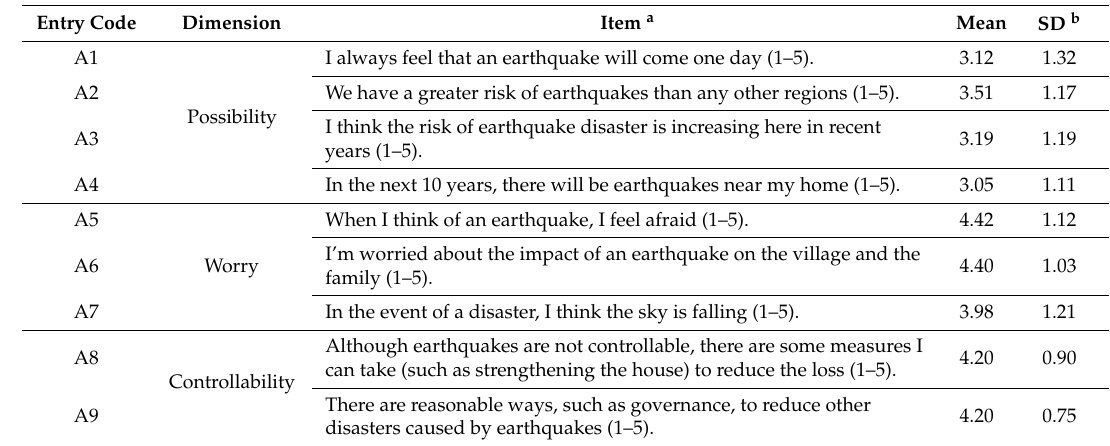
Table 3. Risk perception measurement.